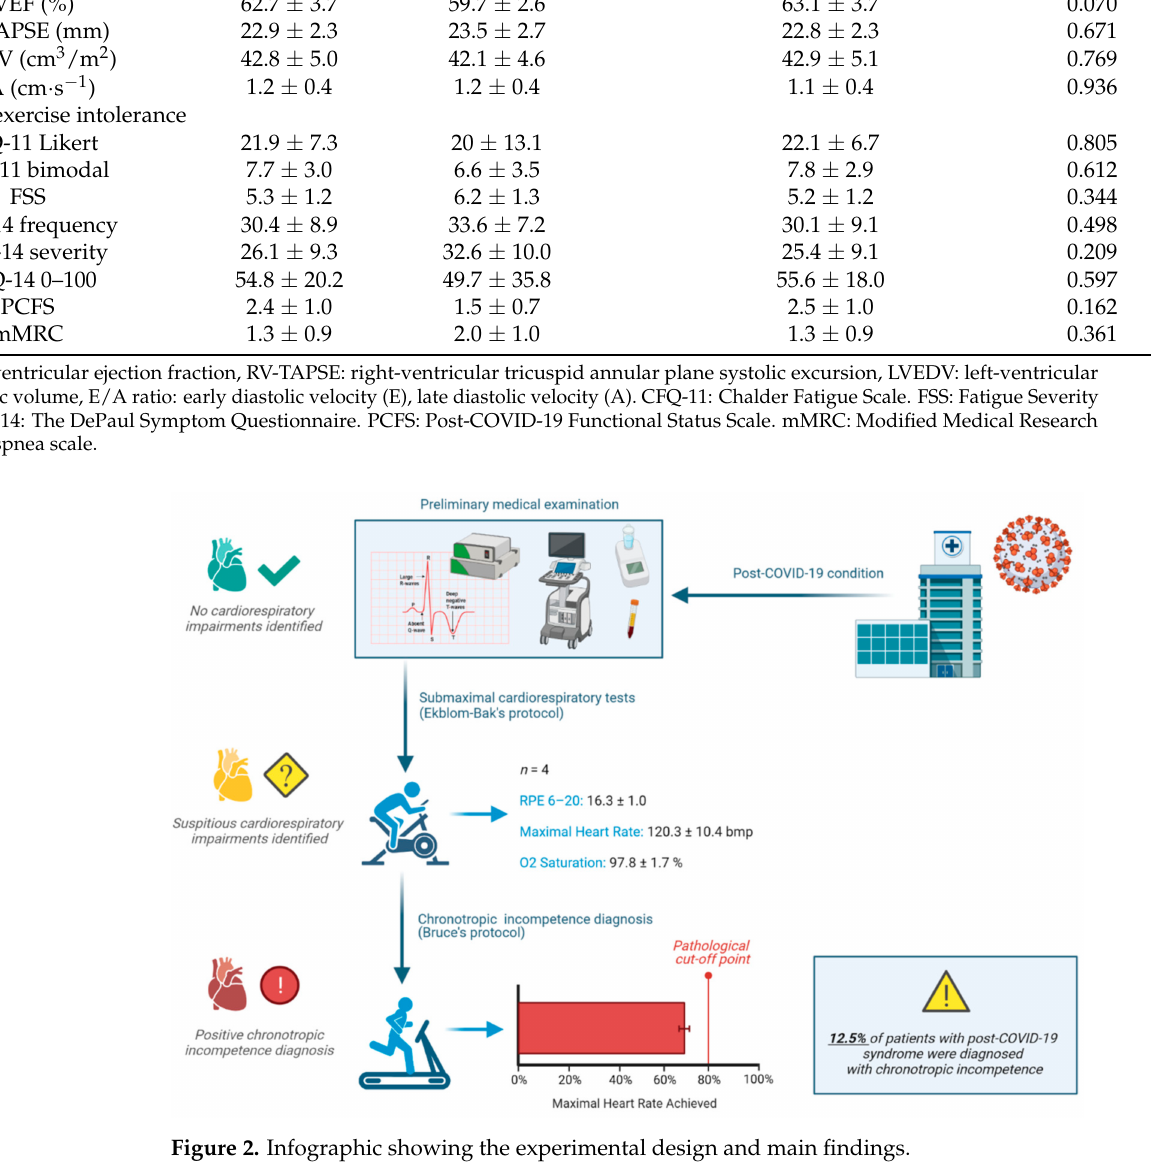
Figure 2. Infographic showing the experimental design and main